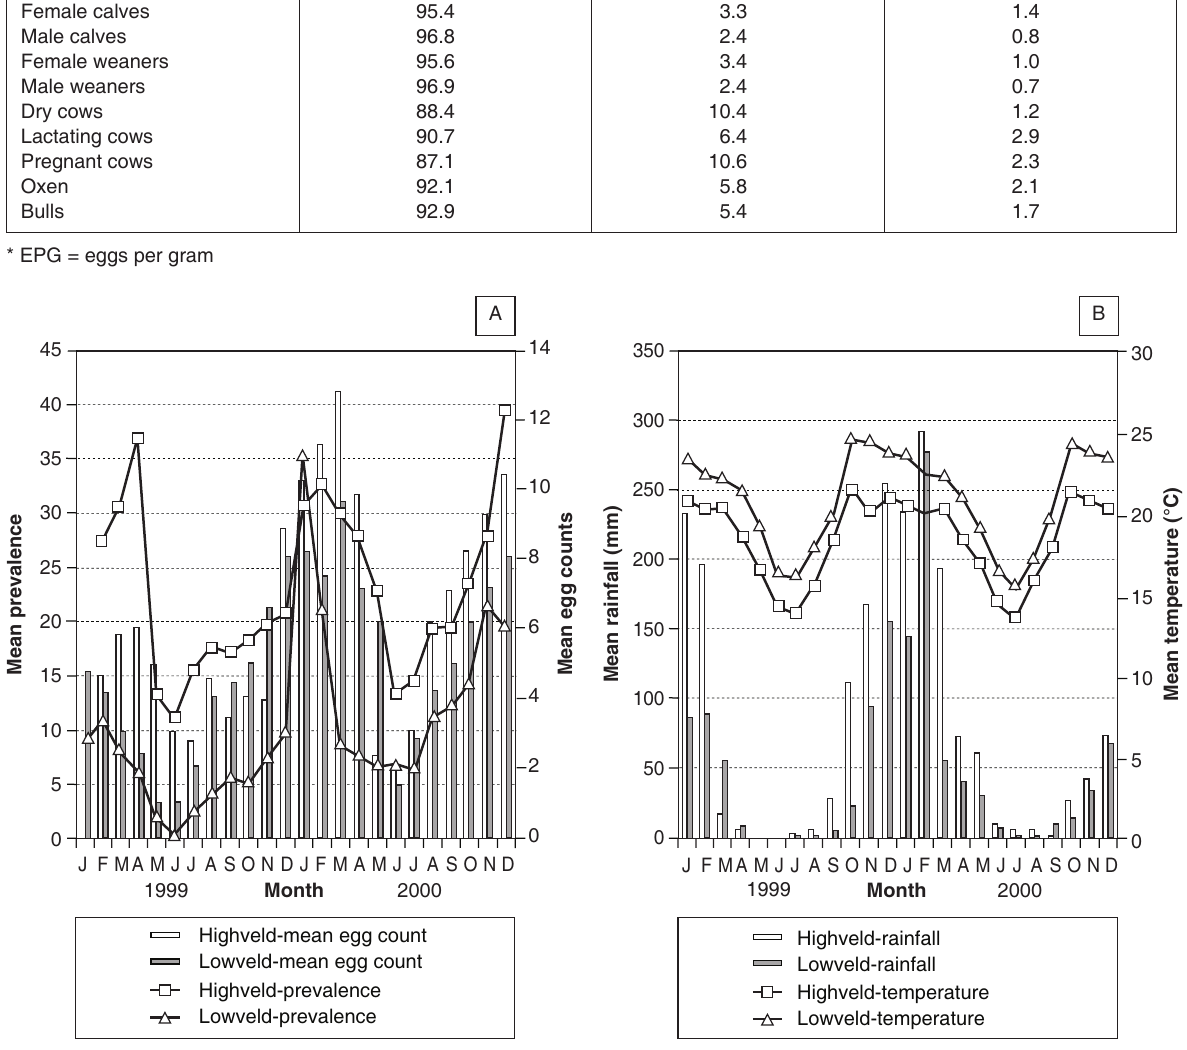
FIG. 2 Mean monthly prevalence (%) and mean monthly faecal egg counts of Fasciola gigantica in cattle (A) and mean monthly rainfall and temperature (B) in the highveld and lowveld communal grazing areas of Zimbabwe sampled for the